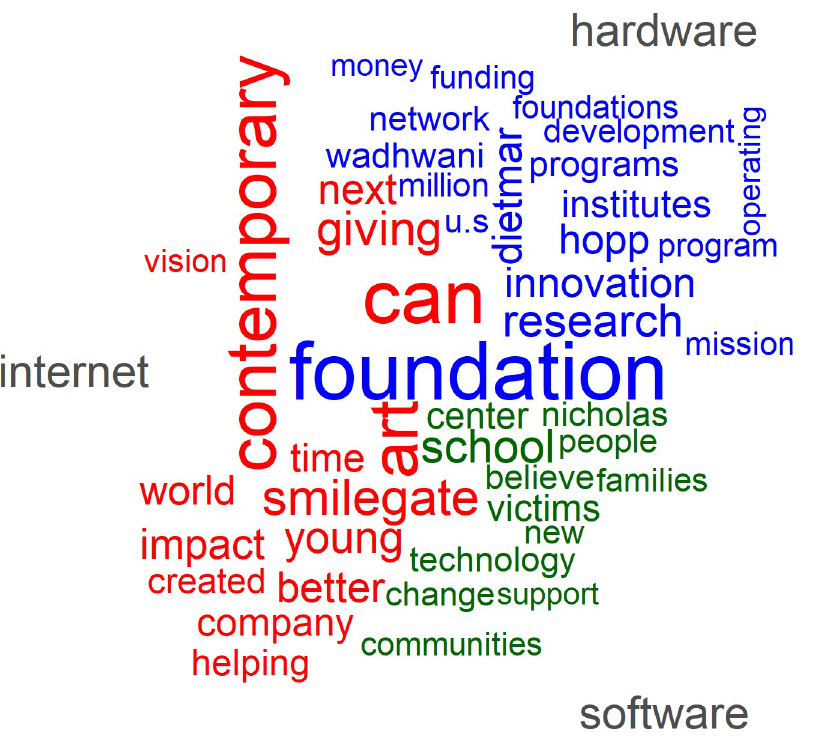
Fig 10. The 50 most frequently used words in foundations’ mission statements by tech